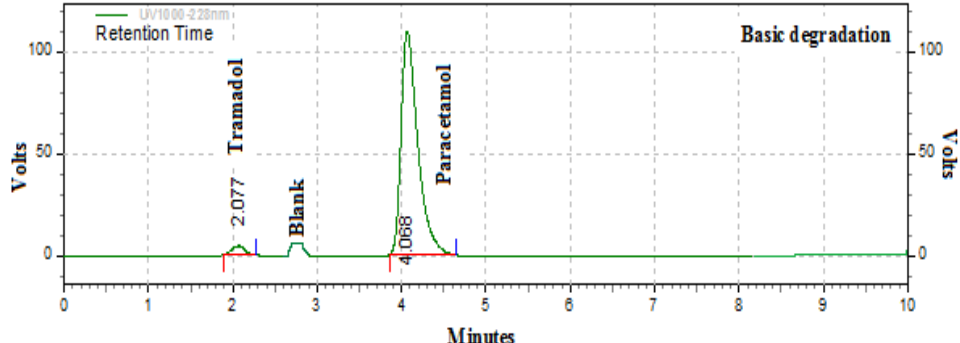
Figure 4 . Representative chromatogram obtained from Basic degradation (0.1 N